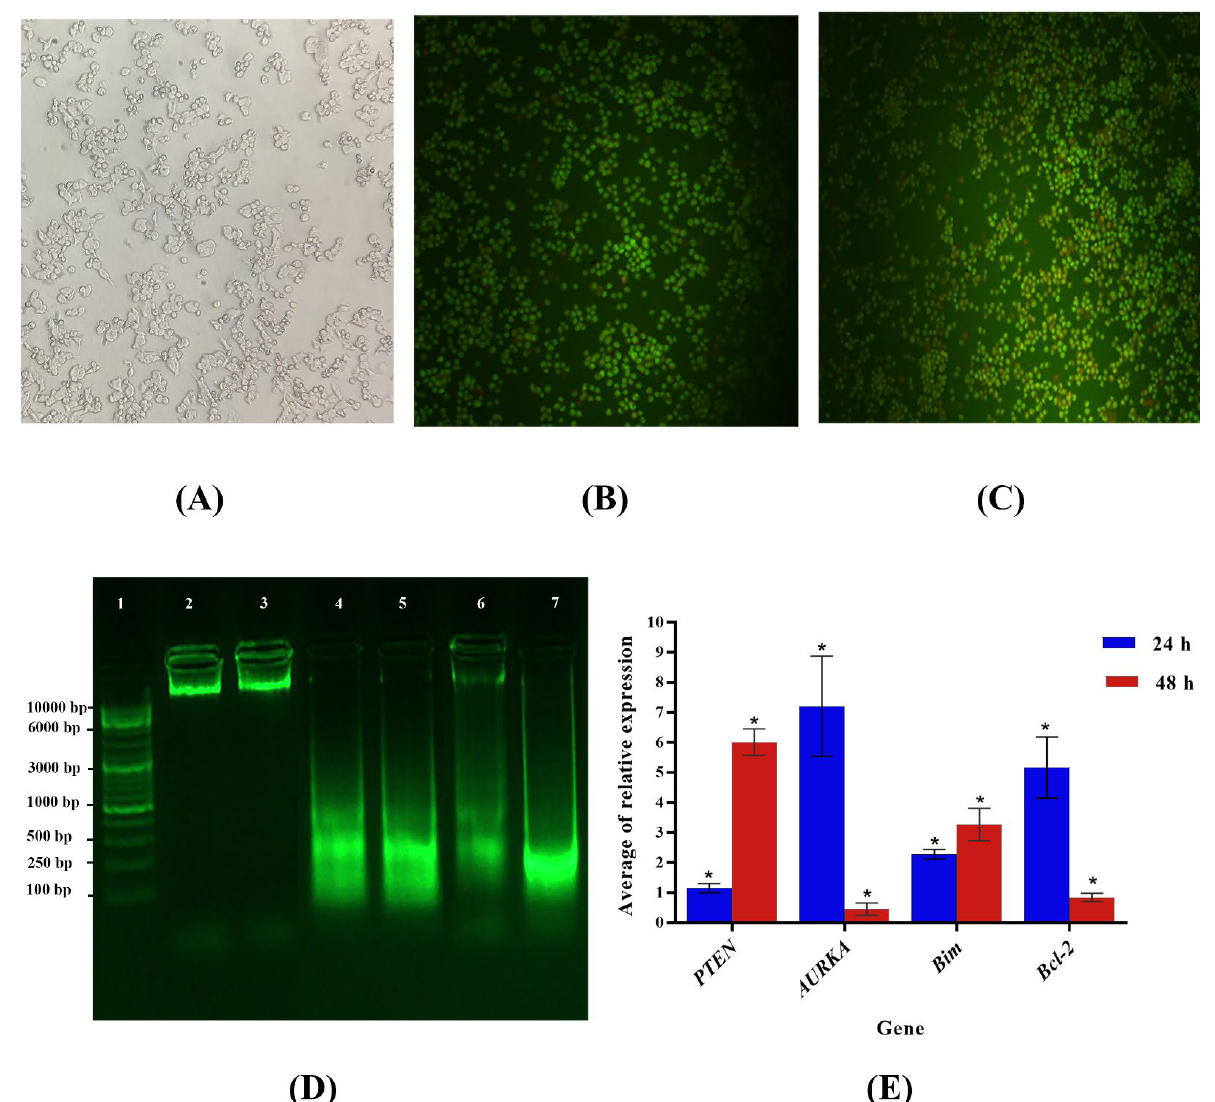
Figure 1. Treatment of MCF-7 cells with OEO essential oils for 24 h led to rapid morphological changes, including cellular contraction, irregular cell shapes, and cellular rounding under an inverted microscope (20 × ) ( A ). Typical morphological changes of MCF-7 cells induced by 39.54 µ g/mL OEO, stained with AO/EB. The images were taken using fluorescence microscopy. The control group, i.e., no treated cells ( B ); OEO treated cells ( C ). Analysis of DNA from the control group (media culture), doxorubicin, and OEO-treated cells by agarose gel electrophoresis. Lane 1: DNA ladder; lane 2 and 3: DNA of the control group (media culture); lane 4 and 5: DNA from doxorubicin-treated cells; lane 6 and 7: DNA from OEO-treated cells ( D ), and the effect of OEO on expression levels of PTEN, AURKA, BIM, and Bcl-2 in the MCF-7 cell line. Data are presented as mean values ± SD, n = 3. (*) indicate significant differences caused by the essential oil ( p < 0.01) ( E ) .